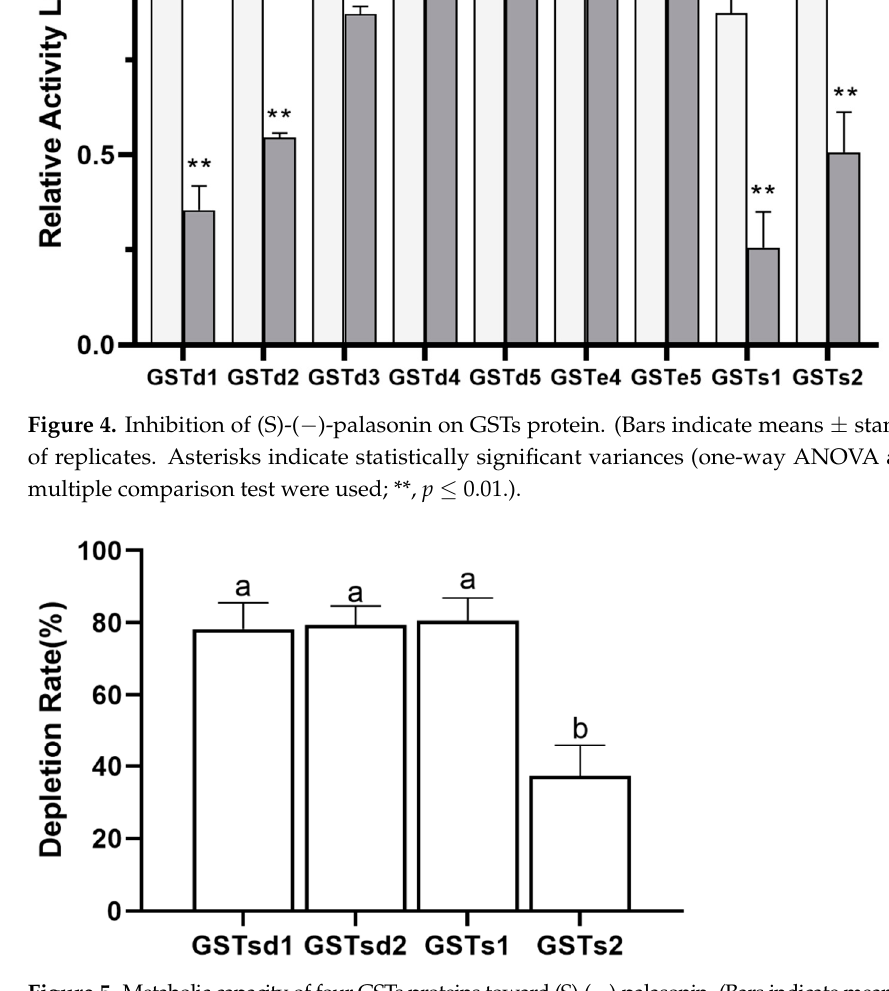
Figure 5. Metabolic capacity of four GSTs proteins toward (S)-( − )-palasonin. (Bars indicate means ± standard errors of replicates. Different alphabets above indicate significant variances ( p < 0.05) calculated with one-way ANOVA, followed by Tukey’s multiple comparison test.).